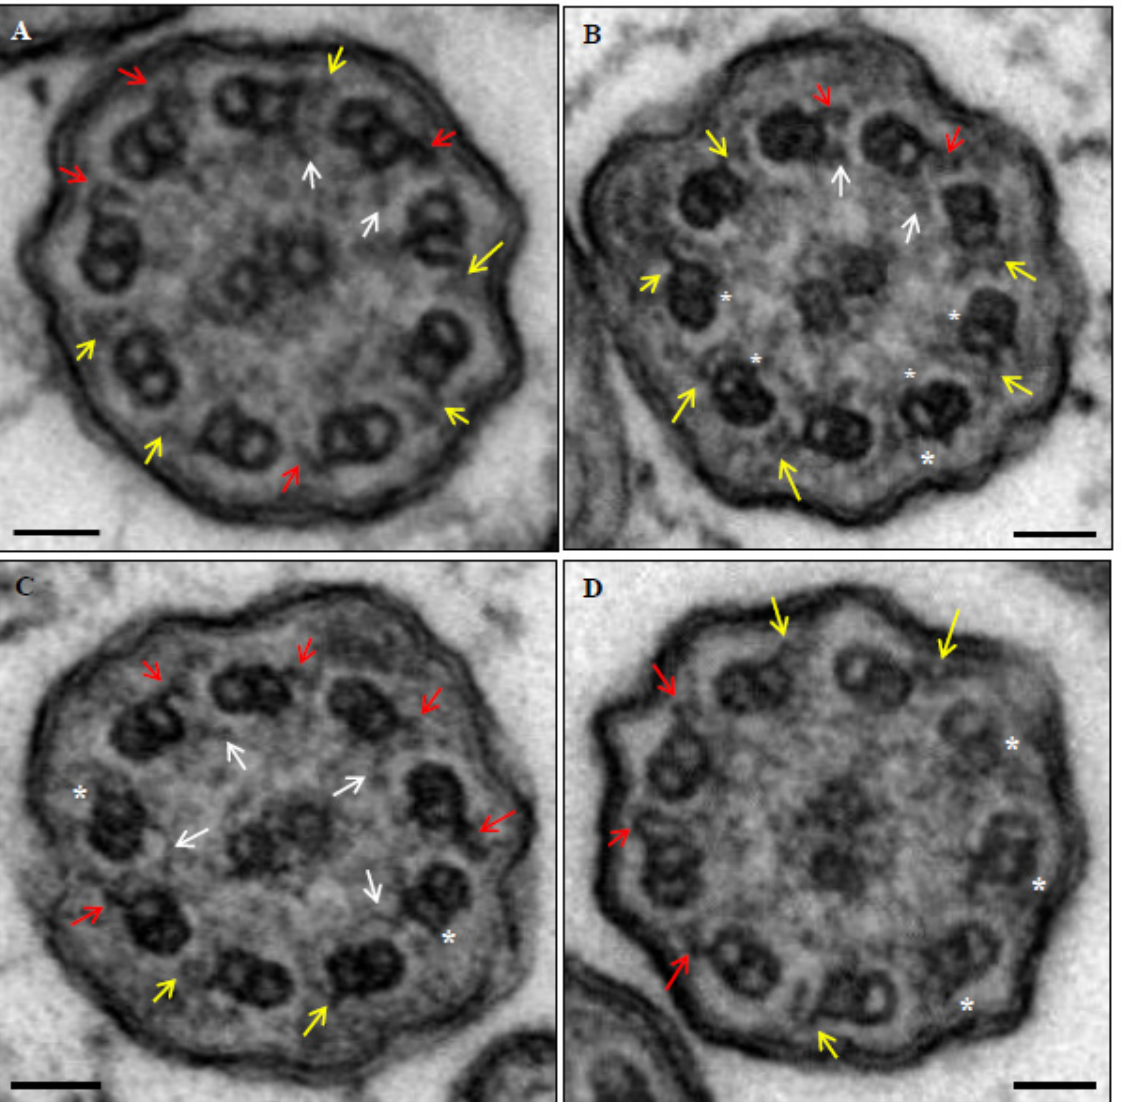
Figure 3. Ultrastructural images of axonemes from patient 6. Normal outer dynein arms (red), decreased dimensions or poor definition of outer dynein arms (yellow), normal inner dynein arms (white arrows), and absence of dynein arms (*). ( A ) Case with absent, decreased dimensions or poor definition of 5 outer and 7 inner dynein arms (abnormal axoneme). ( B ) Case with absent, decreased dimensions or poor definition of 7 outer and 4 inner dynein arms (abnormal axoneme). ( C ) Case with absent, decreased dimensions or poor definition of 4 outer and 5 inner dynein arms (normal axoneme). ( D ) Case with absent, decreased dimensions or poor definition of 6 outer and 9 inner dynein arms (abnormal axoneme). Bars: 50